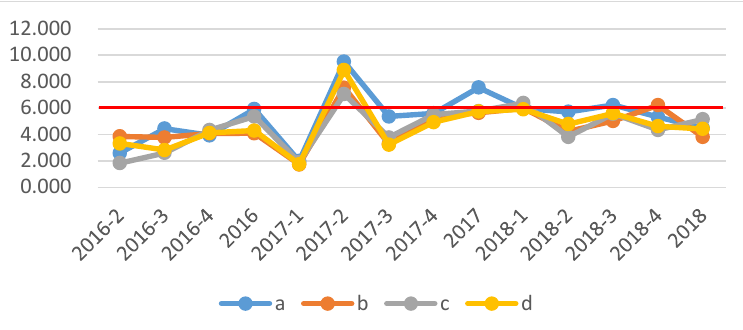
Figure 2. The averages and medians of ΔE 00 in four colored patterns